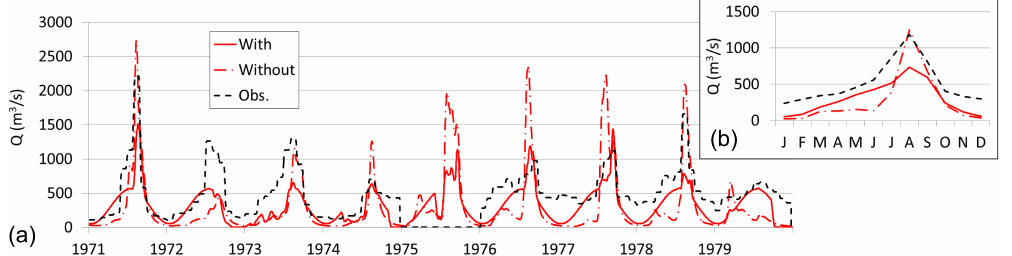
Figure 5. Impact of model parameterisation of reservoir regulation on discharge for (a) monthly streamflow, and (b) annual hydrograph, showing naturalised (without) and regulated (with) conditions at the basin outlet (located at asterisk 2 in Fig. 2).